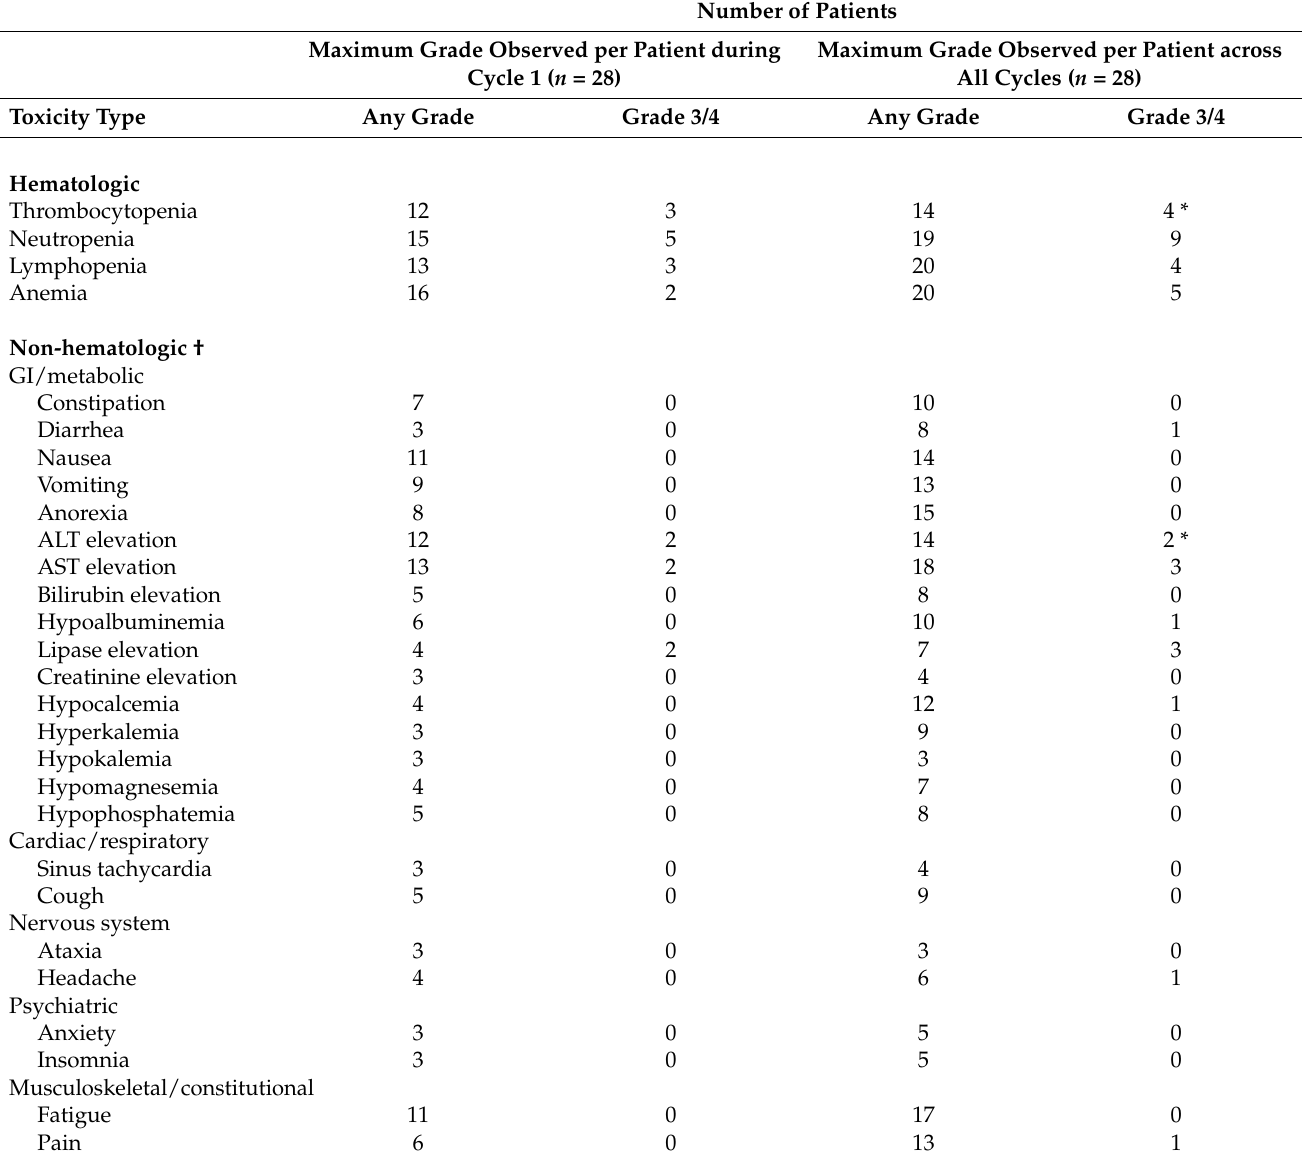
Table 3. Summary of treated-related